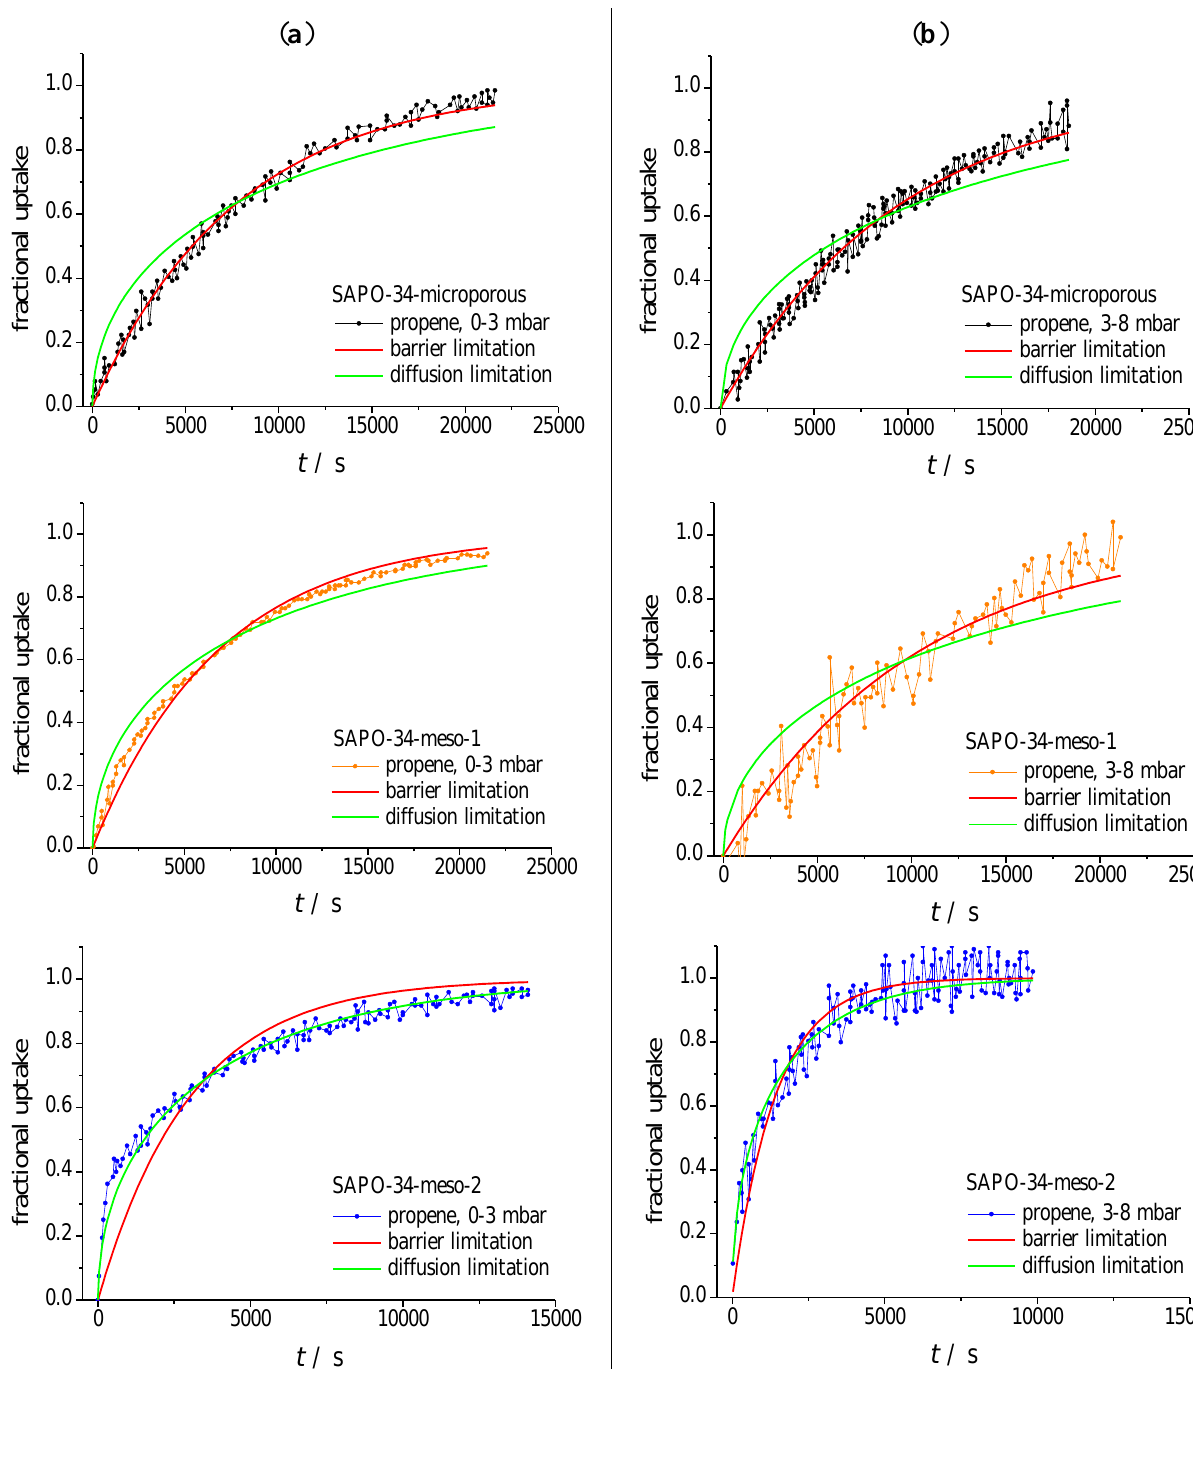
Figure 4. Fitting of uptake curves of propene in SAPO-34-microporous (top), SAPO-34-meso-1 (centre) and SAPO-34-meso-2 (bottom) at 298 K. The green (red) curves represent the results obtained by fitting with the theoretical dependences expected for limitation by diffusion, Equation (1), (surface permeation, Equation (2)). ( a ) 0–3